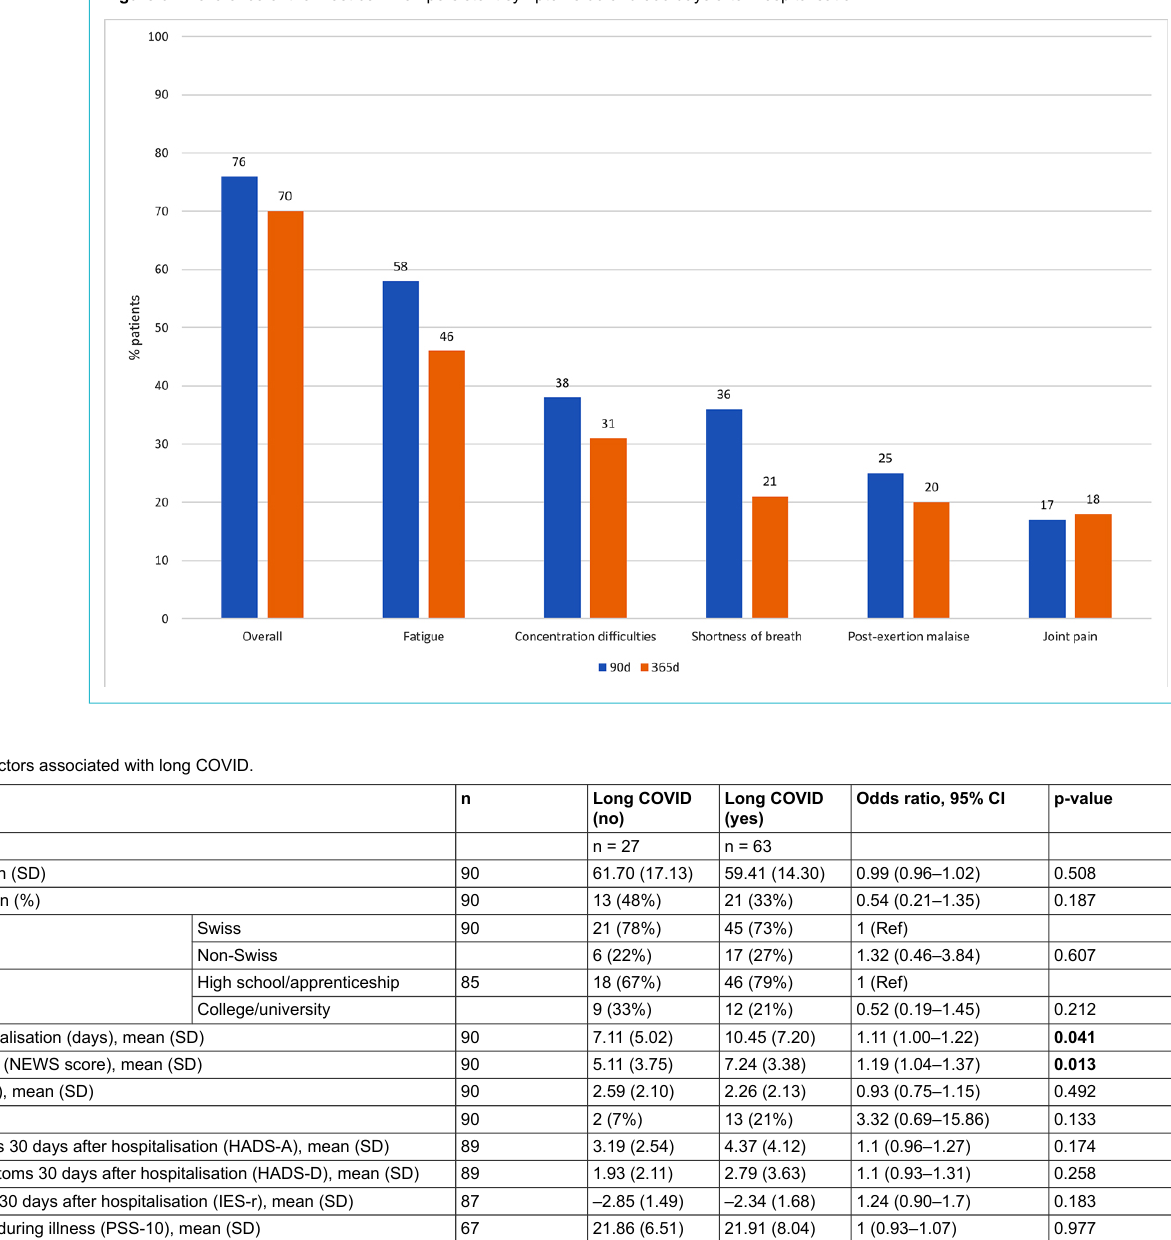
Figure 3: Prevalence of the most common persistent symptoms 90 and 365 days after hospitalisation.